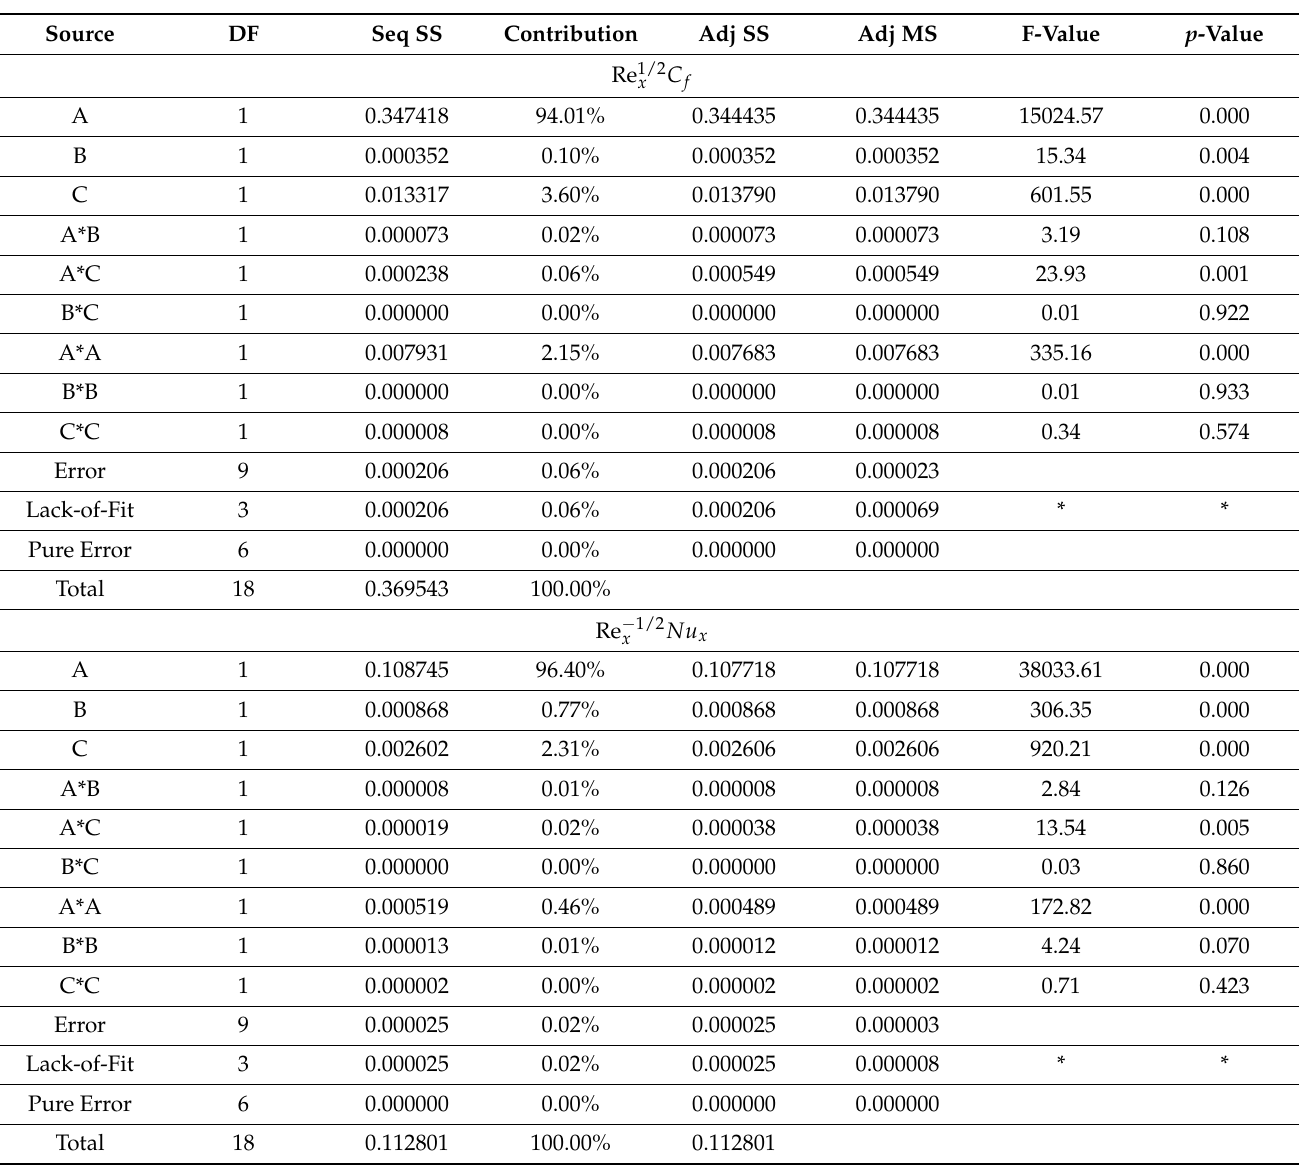
Table 7. Analysis of variance (ANOVA) for the responses.